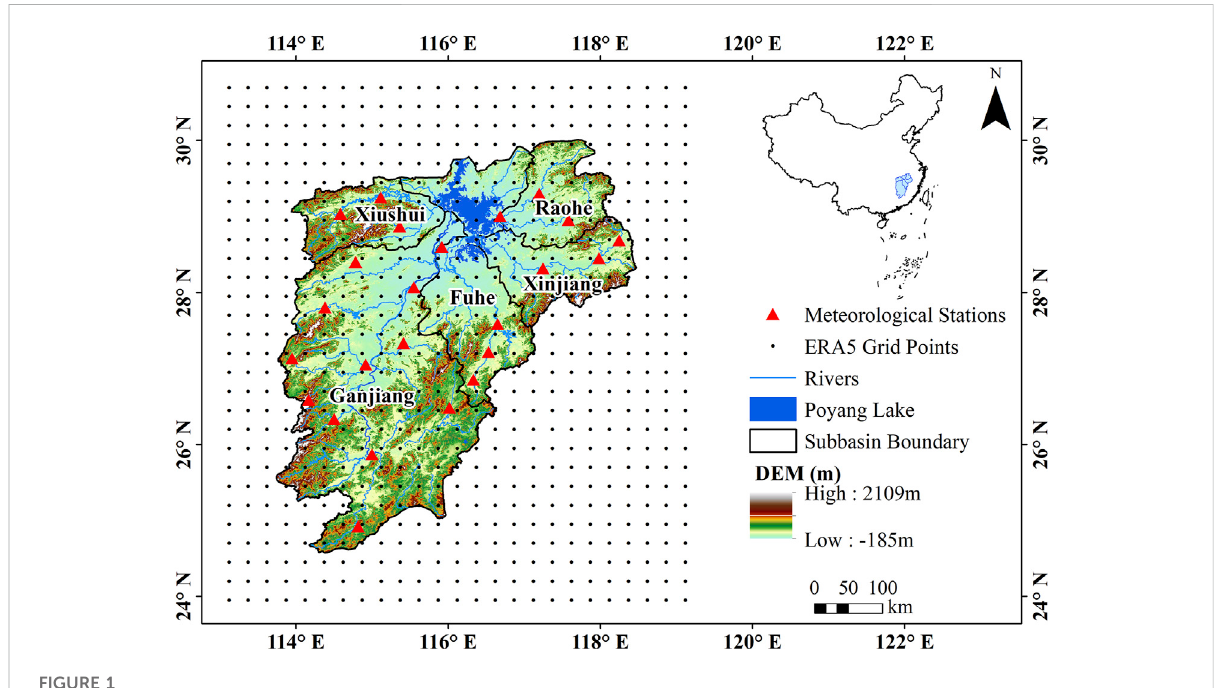
FIGURE 1 Distribution of meteorological stations and ERA5 grid points over the PLB.